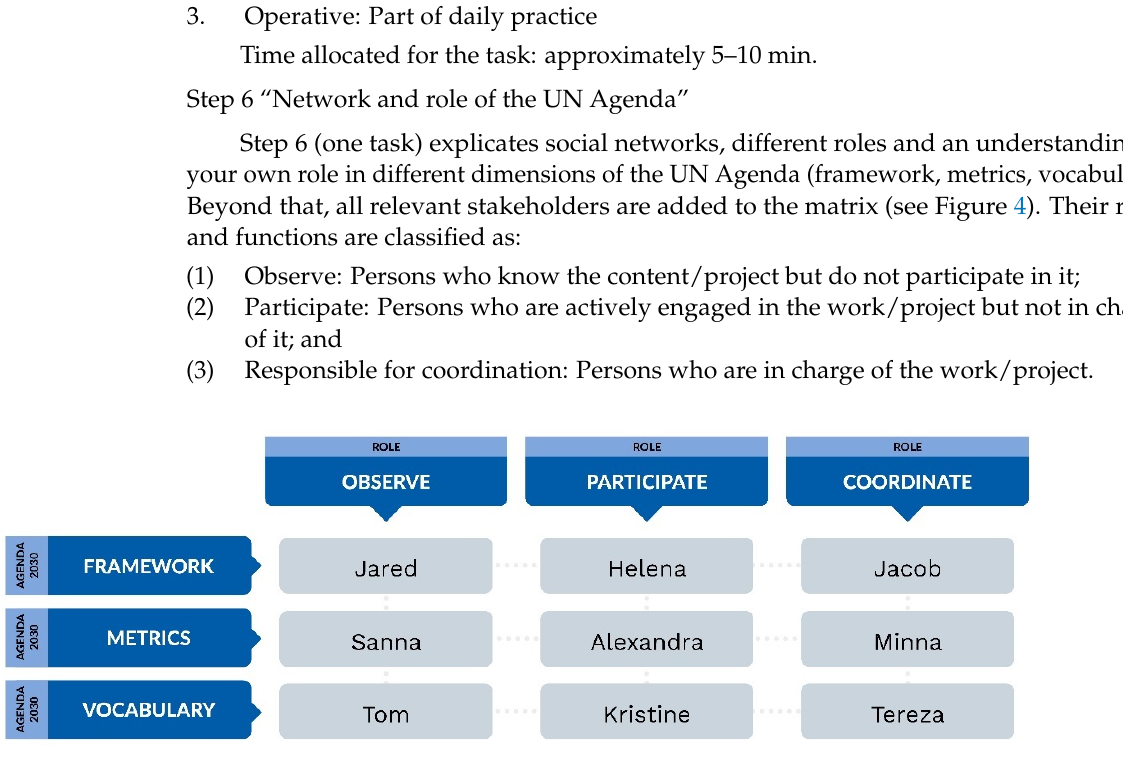
Figure 4. Step 6: identifying project network in relation to UN Agenda 2030 roles (Step 4a).